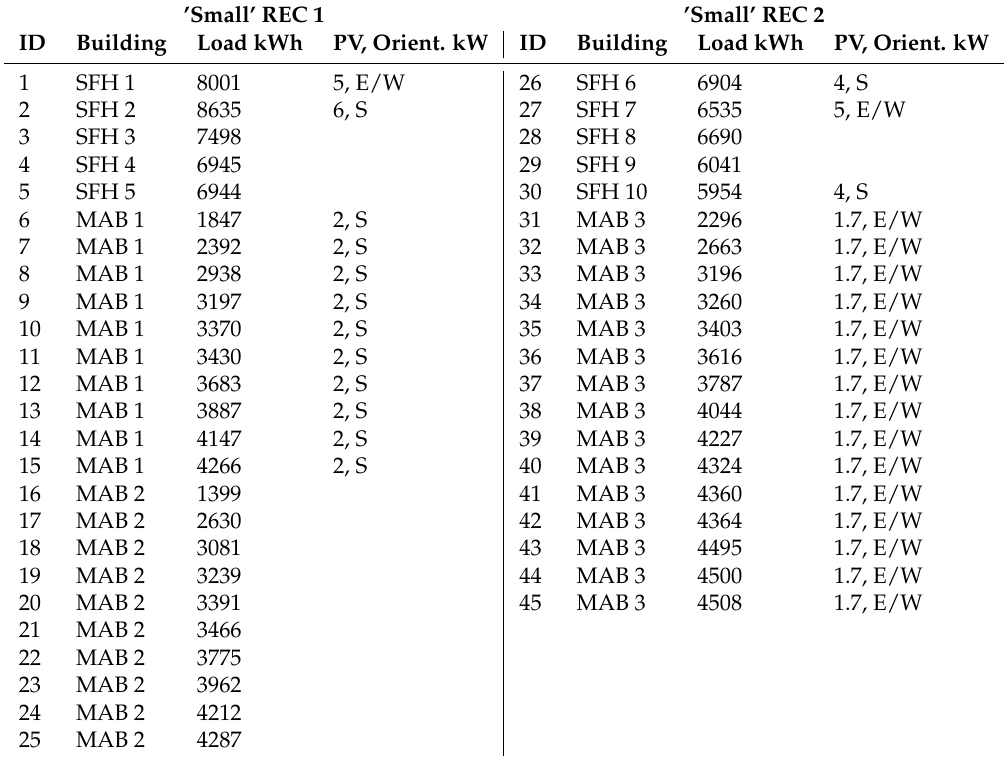
Table 2. Residential customers, their load and PV systems (orientations: S–south, E/W–east/west). It needs to be noted that the PV systems on the SFHs are privately-owned. In contrast, PV systems on MABs’ rooftops are externally-owned (e.g., by a contractor). However, the MAB residents are allocated fixed shares of the PV system: They can consume as much electricity as possible and pay the external PV system owner, but they do not sell PV electricity themselves, as they do not own the in-house PV